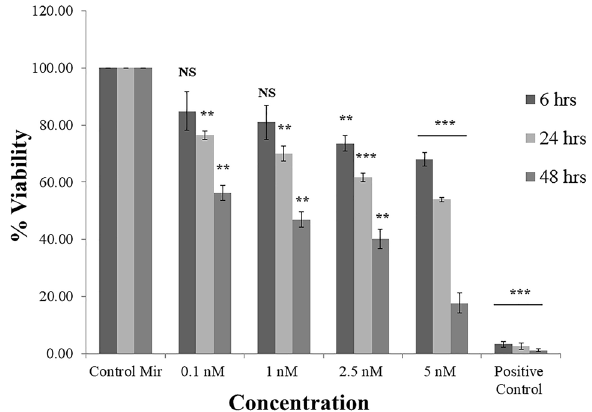
Figure 3. Concentration and time dependent percent MTT reduction of miRNA coated Au Nps in MCF-7 cells. A negative control miRNA coated with Au Nps was considered as Control miRNA. The viability of the control cells was considered as 100%. Values represents mean ± S.E. of three independent experiments (*p < 0.05, **p <